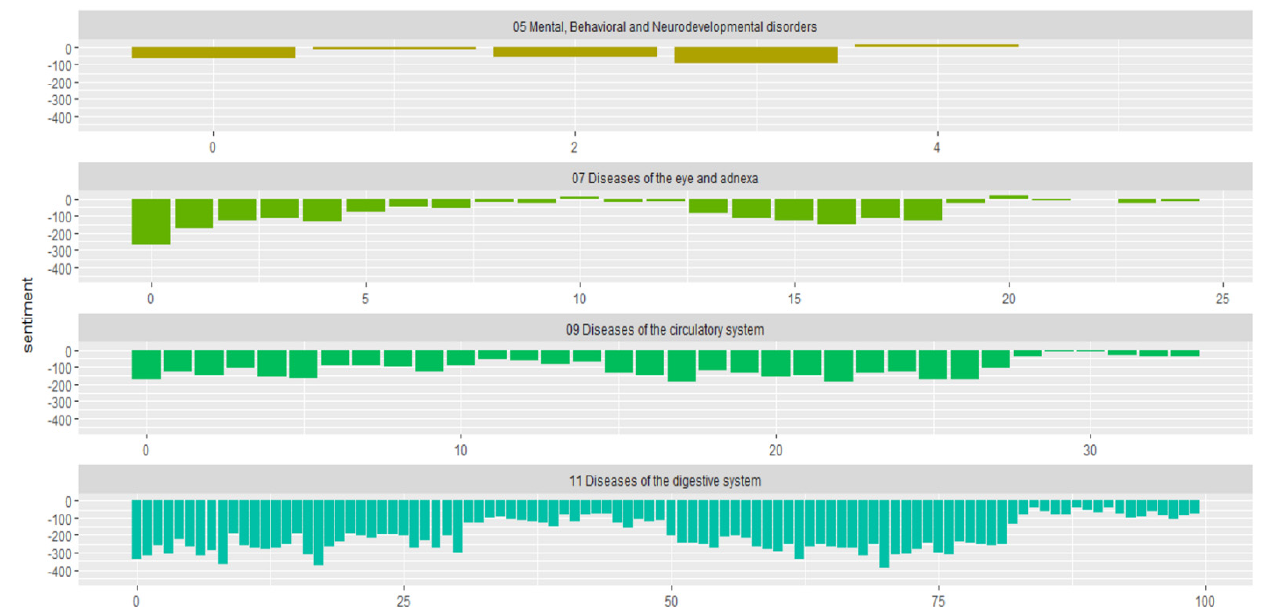
Figure 3. Lexicon based sentimental scores of the ICD 10 disease types (this is the plot of each disease sentiment changes towards more negative or positive over the times appearing in a dataset).